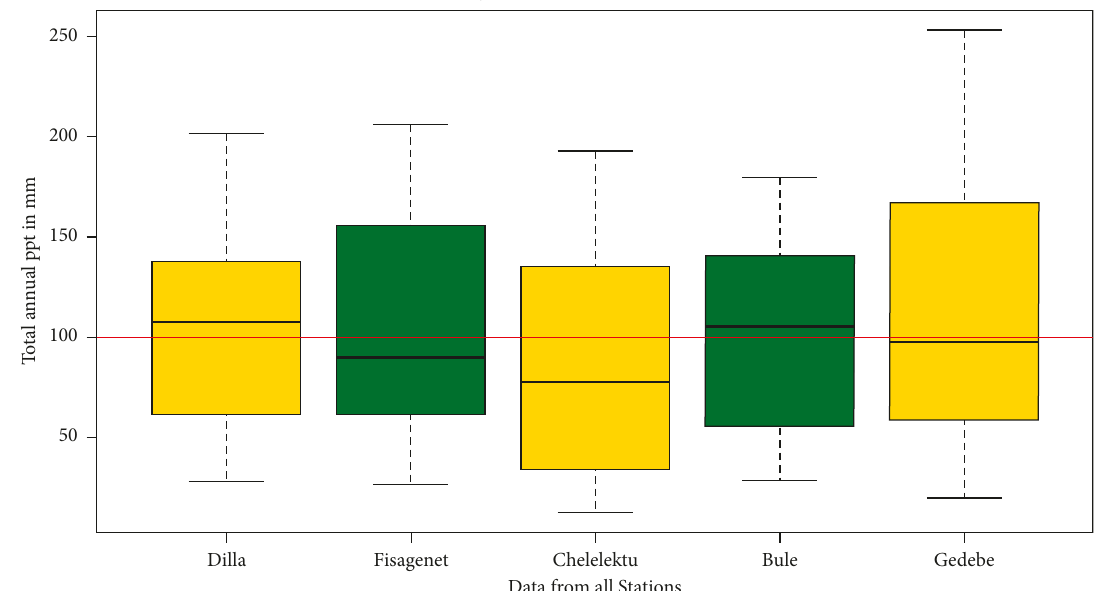
Figure 6: Annual boxplots of rainfall data at five local stations within the study zone for the last 30 years. Source (National Meteorological Agency